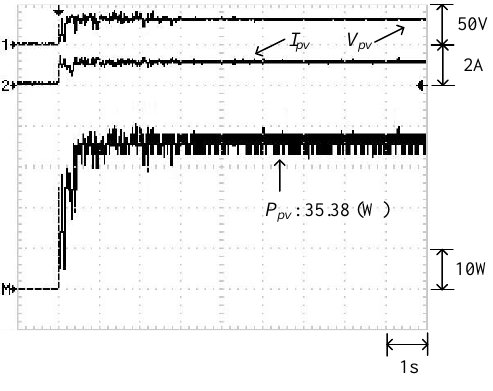
Figure 16. Maximum power point of Case 3 determined through the conventional PSO algorithm.